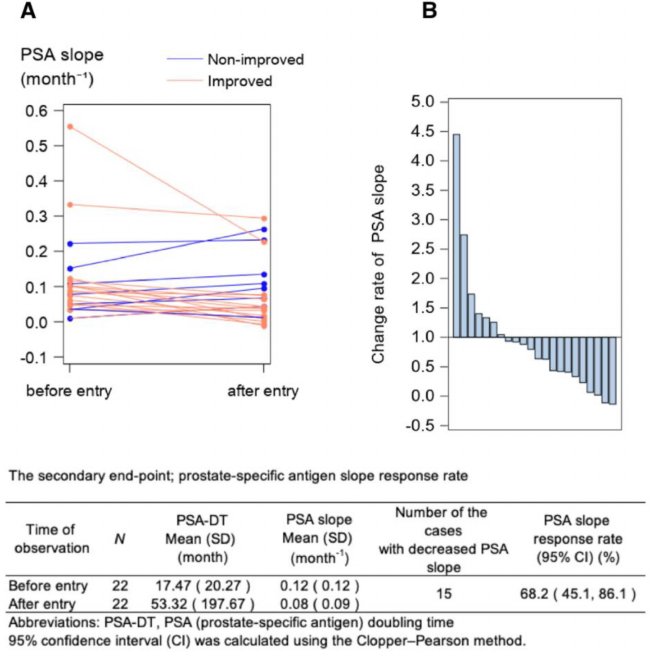
The mean PSA slopes before and after baseline were 0.12 month − 1 and 0.08 month − 1 , respectively (Figure 2). Figure 2A shows the actual alteration in the PSA slope before and after baseline. The PSA slopes in all patients before baseline were positive. Of the 22 patients, 15 had a PSA slope ratio <1, and the PSA slope response rate was 68.2% (95% CI: 45.1, 86.1) (Figure 2B).